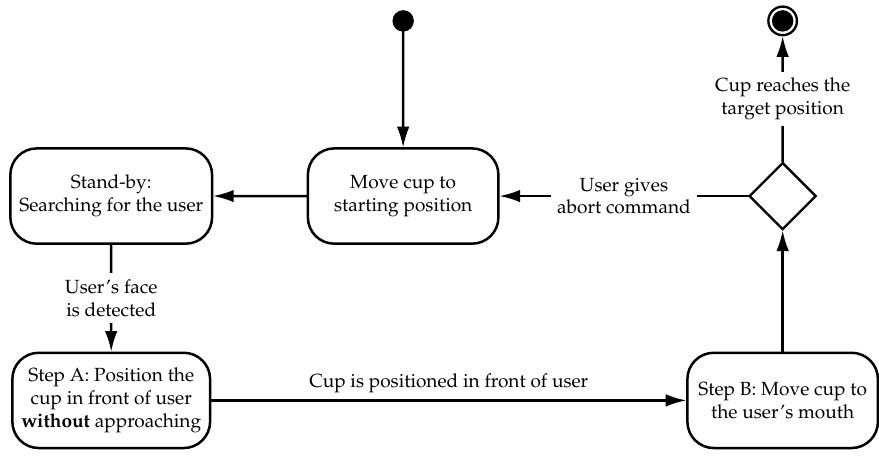
Figure 7. State machine of the navigation algorithm to perform the delivery of the cup. The cup delivery process begins after filling and grasping of the cup. In the first step, the cup is moved to a predefined starting pose which is approximately 30 cm in front of the user. This position allows the visual tracking system to detect the user which is necessary to perform the rest of the cup delivery. The setup is illustrated in Figure 8. Stand-by, searching for the user: After reaching the starting position, the robot goes into a stand-by mode and uses the visual tracking system to search for faces. Detected faces are evaluated by the size of the bounding box to roughly estimate the distance. Small faces are rejected as they are too far away to interact with.